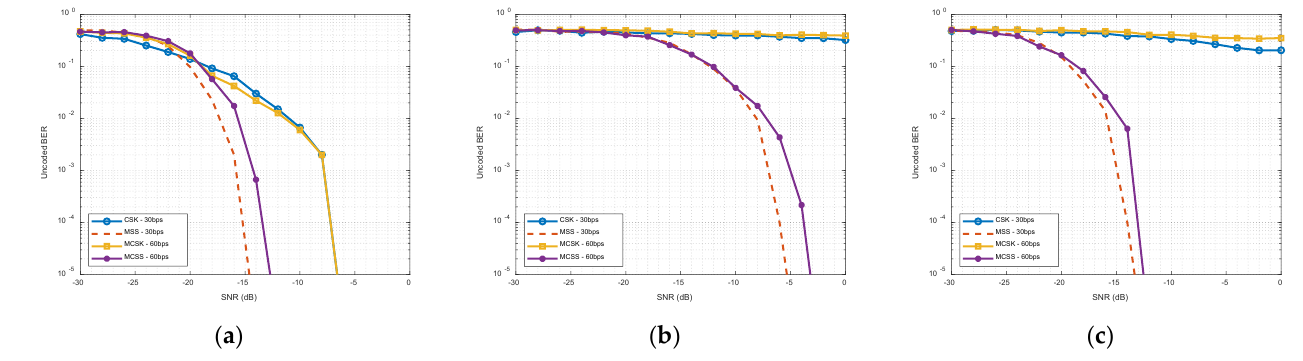
Figure 10. BER performance at the same symbol rate. ( a ) is when there is no artificial Doppler shift, ( b ) is with Doppler and no compensation, ( c ) is when Doppler is compensated.